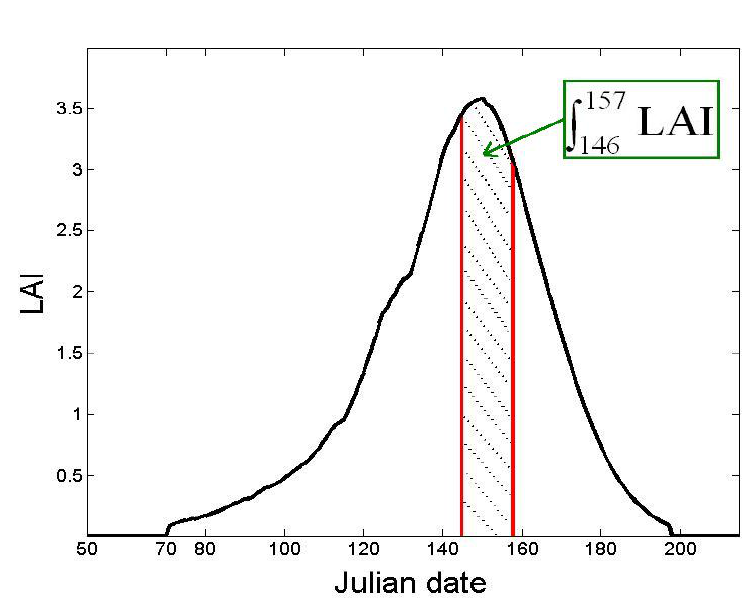
Figure 7. Principle of cereal yield estimations, based on the integral of the LAI over the period of maximum canopy development (A LAI ).